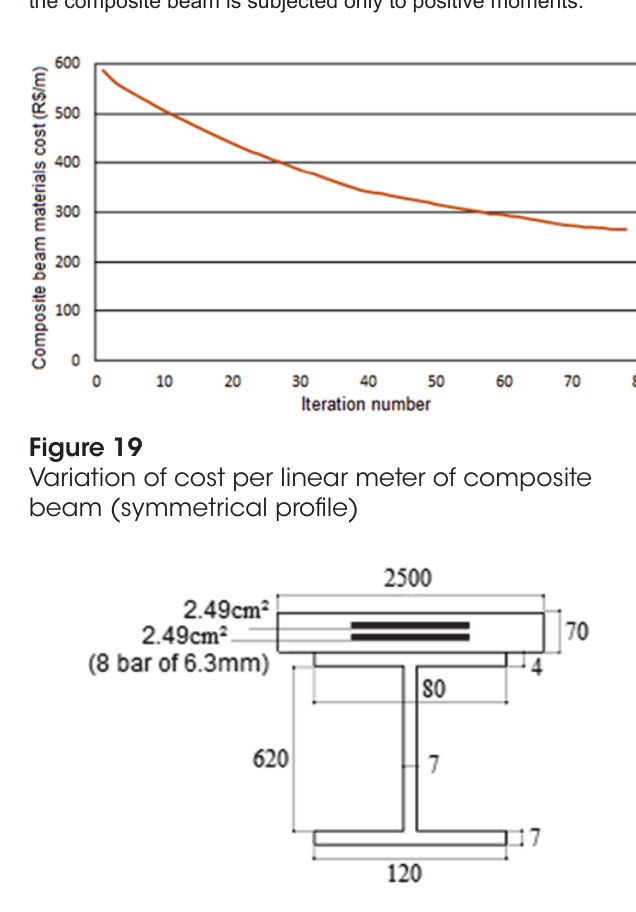
Optimum non-symmetric section obtained by the algorithm (dimensions in